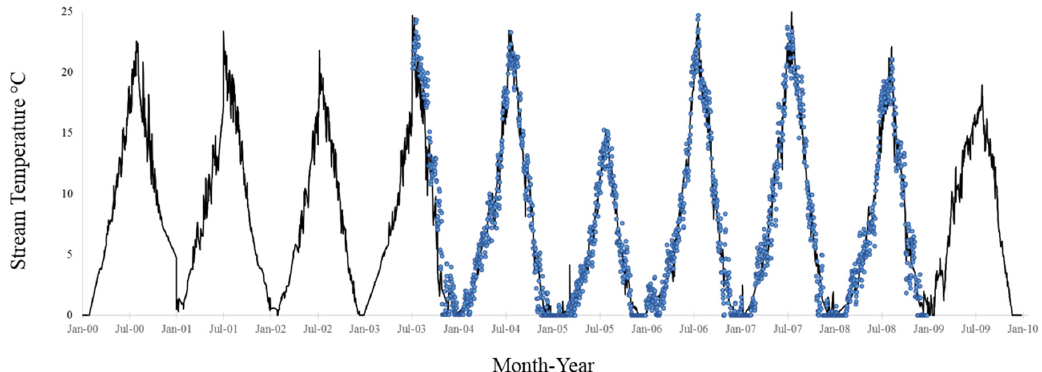
Figure 8. Example of observed and predicted daily mean stream temperature from one site across 10 years (2000–2009). The site is located on the North Fork John Day River above the confluence with Camas Creek. Blue dots are observed daily mean stream temperature and the gray line is estimated daily stream temperature from site-specific models in years where data are available, and the black line is from HUC-based models.